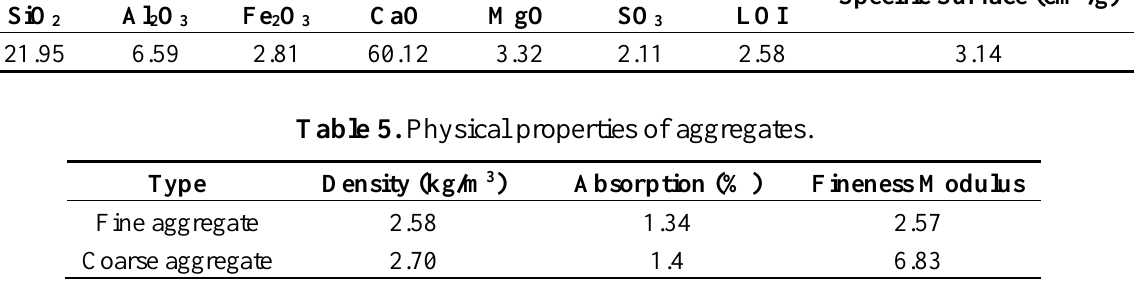
Table 6. Mix proportion of concrete. W/C: water–cement ratio; S/a: fine aggregate percentage.